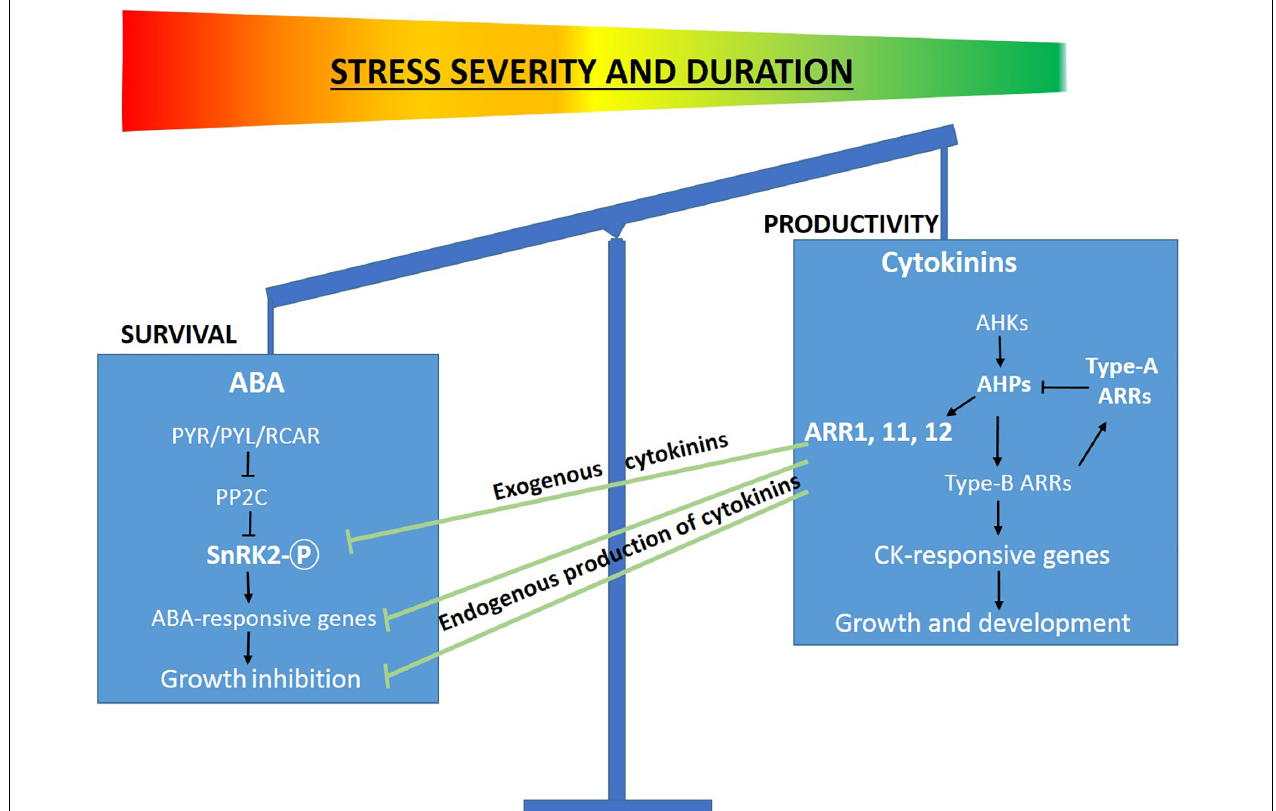
FIGURE 9 | The balance between stress tolerance and productivity modes is reflected by the antagonistic action of ABA and CK signaling. Schematic representation of the working model demonstrating the regulatory role of CKs in promoting productivity under abiotic stress by inactivating SnRK2 the key component of ABA signaling pathway. Under stress conditions, CKs inactivate SnRK2 and inhibit ABA signaling pathway and the downstream upregulation of stress related genes and growth promotion via CK-responsive genes. The model suggests a molecular mechanism underlying the behavior of CK over-expressing transgenic plants under mild abiotic stress conditions for short periods. This model has been partially adapted from Claeys and Inze